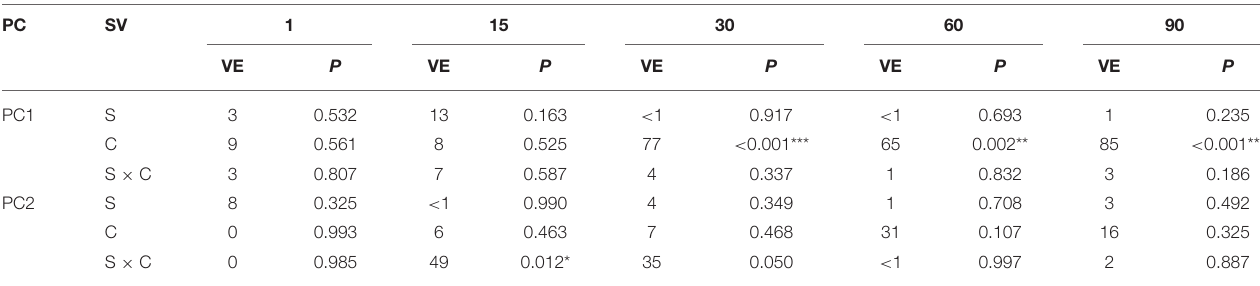
TABLE 7 | Multivariate analysis of variance (the two-way MANOVA) for the PC1 and PC2 based on the data of the DGGE indices for each sampling day (1, 15, 30, 60 and 90) as affected by the bacterial strain (S), concentration (C), time (T) and their interaction (S × C). PC SV